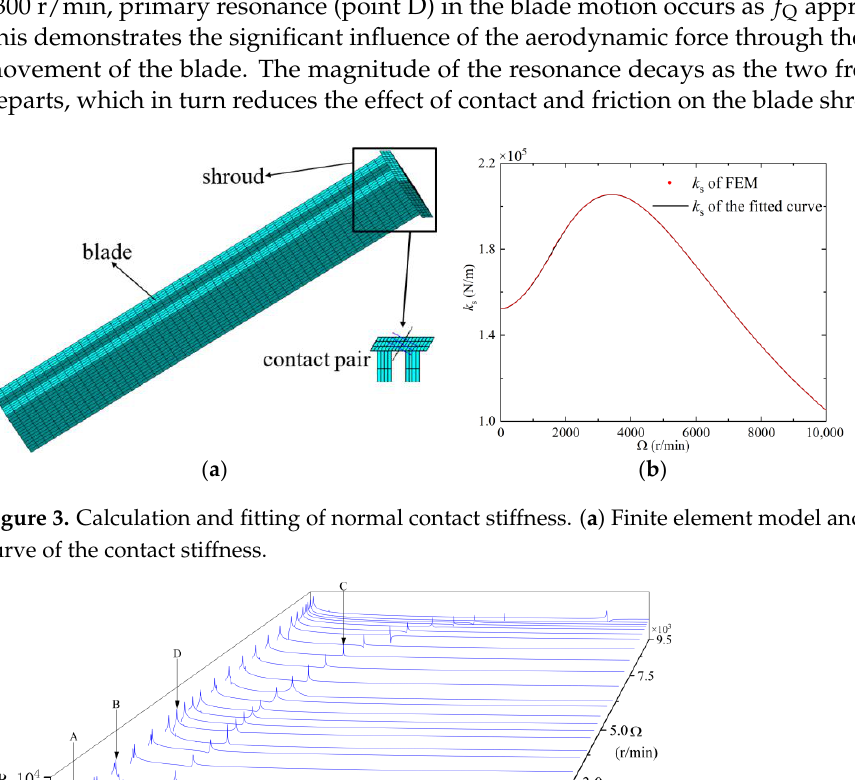
Table 1. Gross parameters of the shrouded blisk.